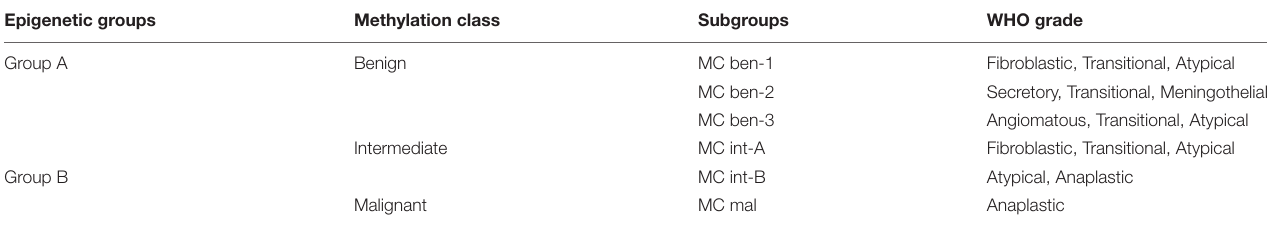
TABLE 4 | The methylation-based classification (2017) and associations with WHO